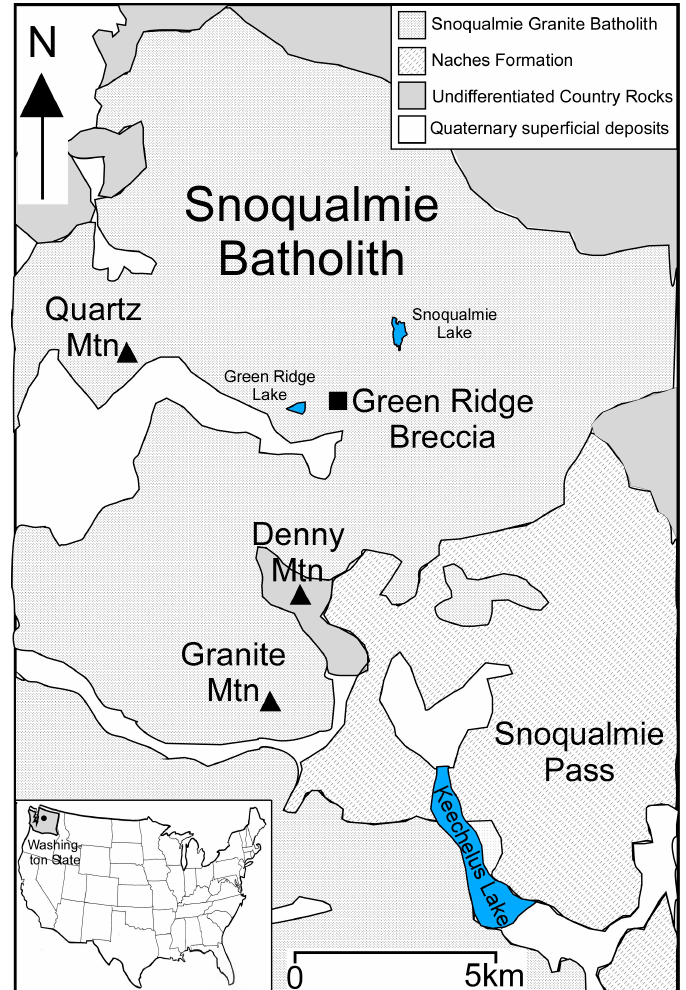
Figure 1. Simplified geological map of the Snoqualmie Batholith and its country rock showing the location of the Green Ridge Breccia (after [22]).